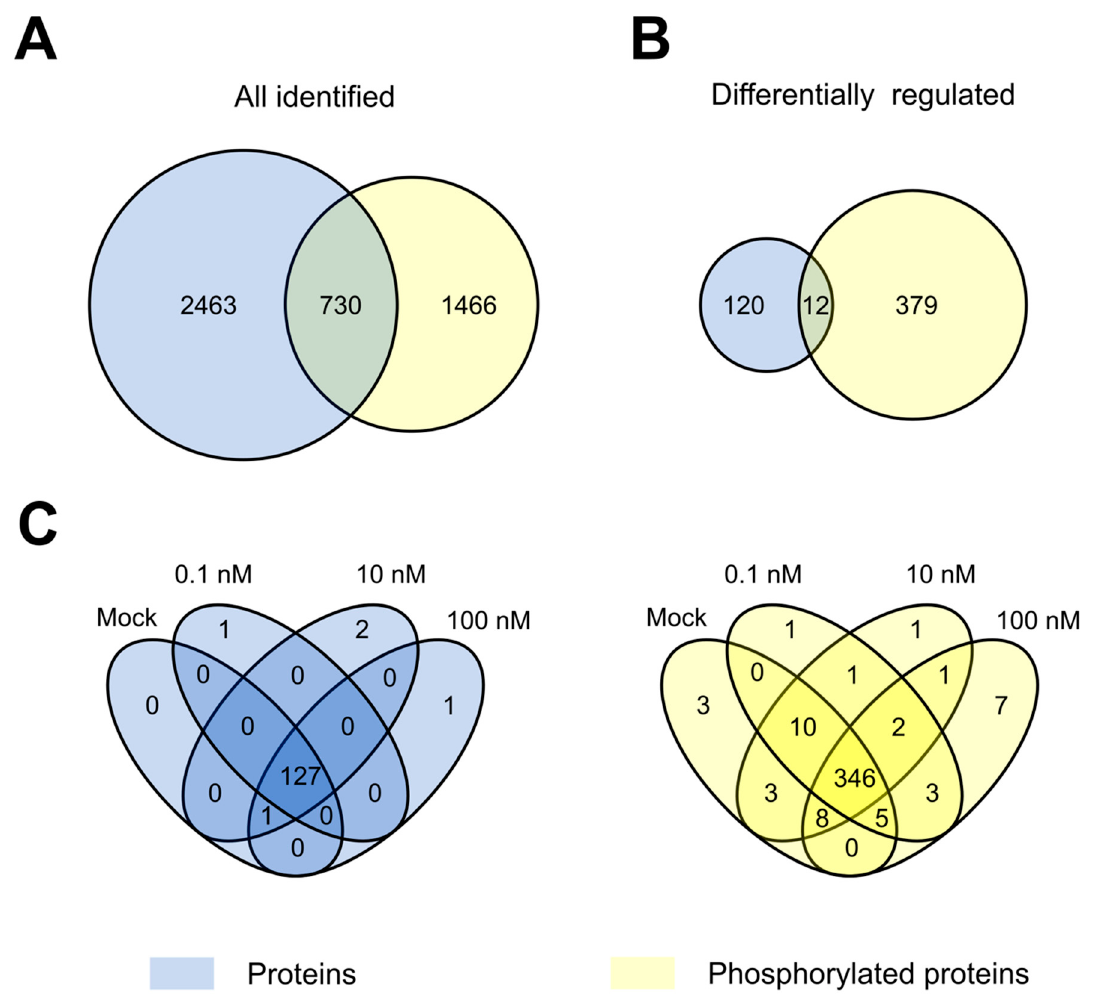
Figure 2. Comparison of NAA proteome and phosphoproteome data. ( A , B ) Overlap of all identified and differentially regulated proteins (blue; 3193 protein groups) and phosphoproteins (yellow; 6548 phosphosites mapped to 2196 proteins) in proteome and phosphoproteome datasets. ( C ) Overlap between differentially regulated (including “unique” ones) proteins (blue) or phosphoproteins (yellow) at different NAA concentrations.